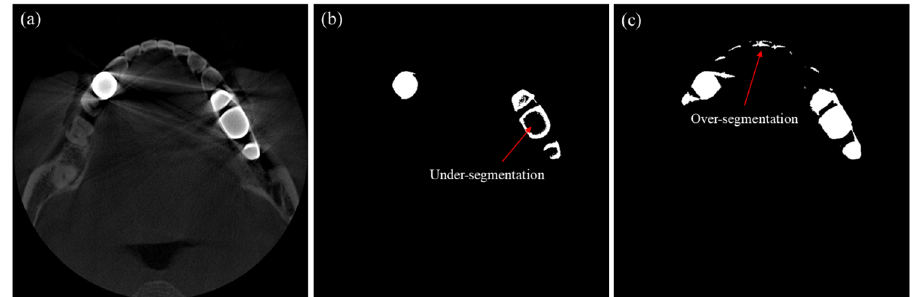
Figure 6. Examples of segmentation error when global thresholding is used for the segmentation.